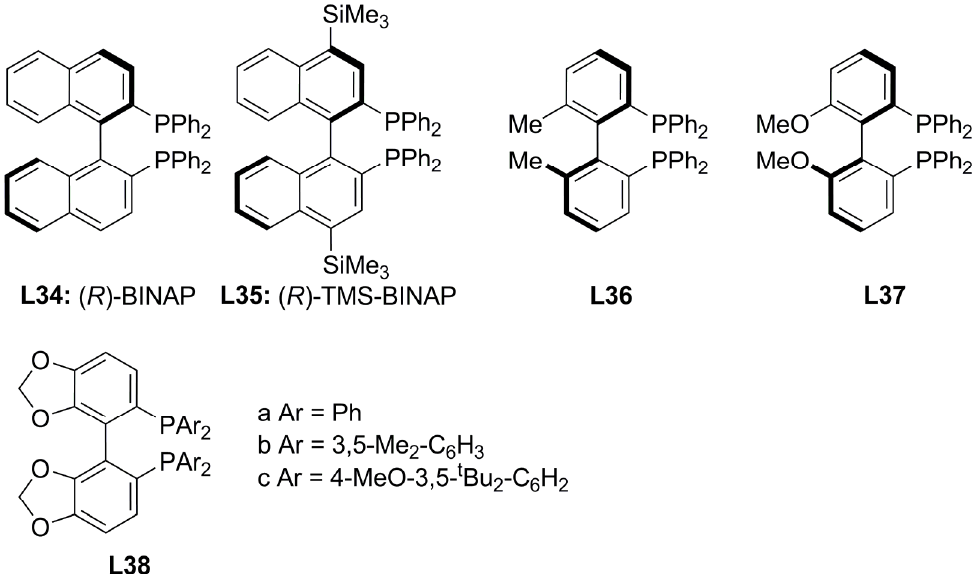
Figure 15. Main atropoisomeric